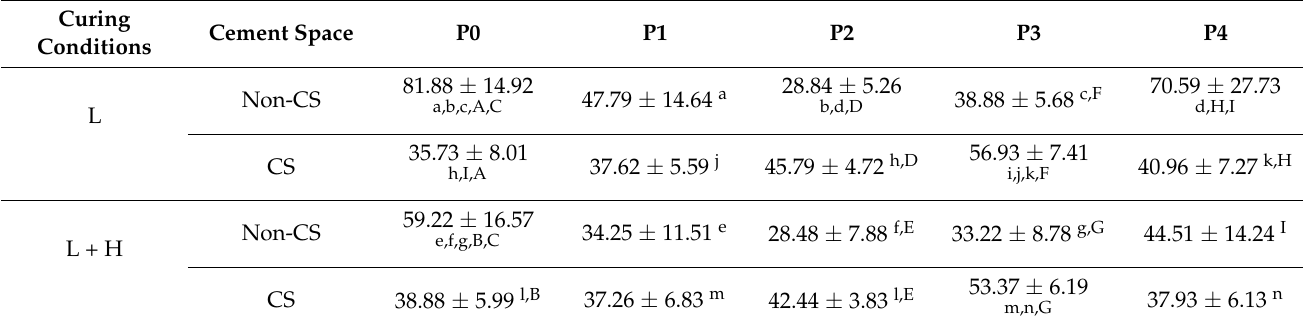
Table 4. Internal adaptation for five reference points were chosen for crowns.